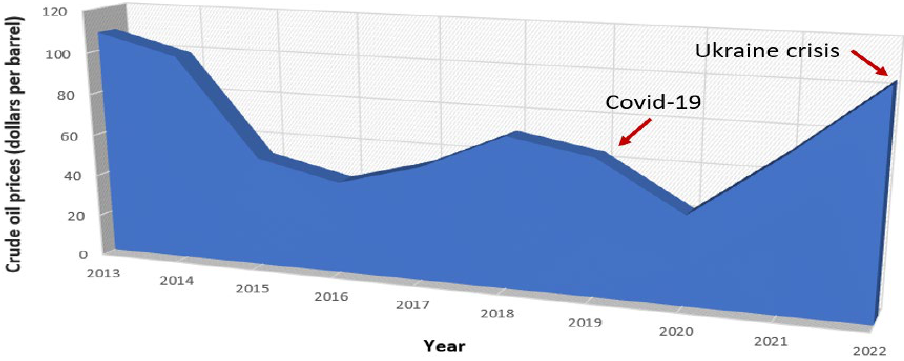
Figure 1. Crude oil prices from 2013 to 2022, based on data from US Energy Information Administration ― EIA [1]. COVID-19 and recent Ukraine crisis-derived price increases are shown (red arrows).